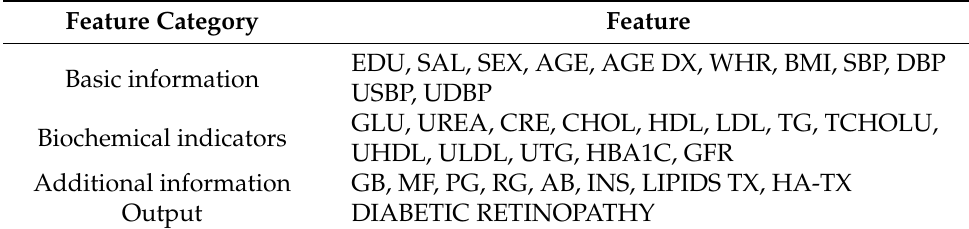
Table 1. Features gathered from the Mexican